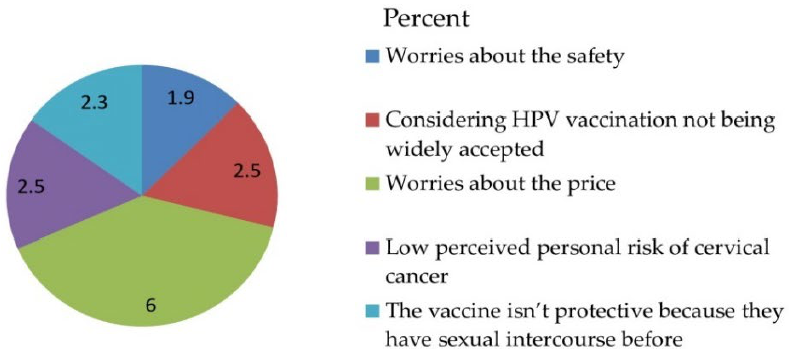
Figure 4. Obstacles to the acceptance-related questionnaire of the respondents on awareness, ac- ceptance, and associated factors of human papillomavirus vaccine among parents of daughters in Hadiya zone, southern Ethiopia, 2021 (n = 530).